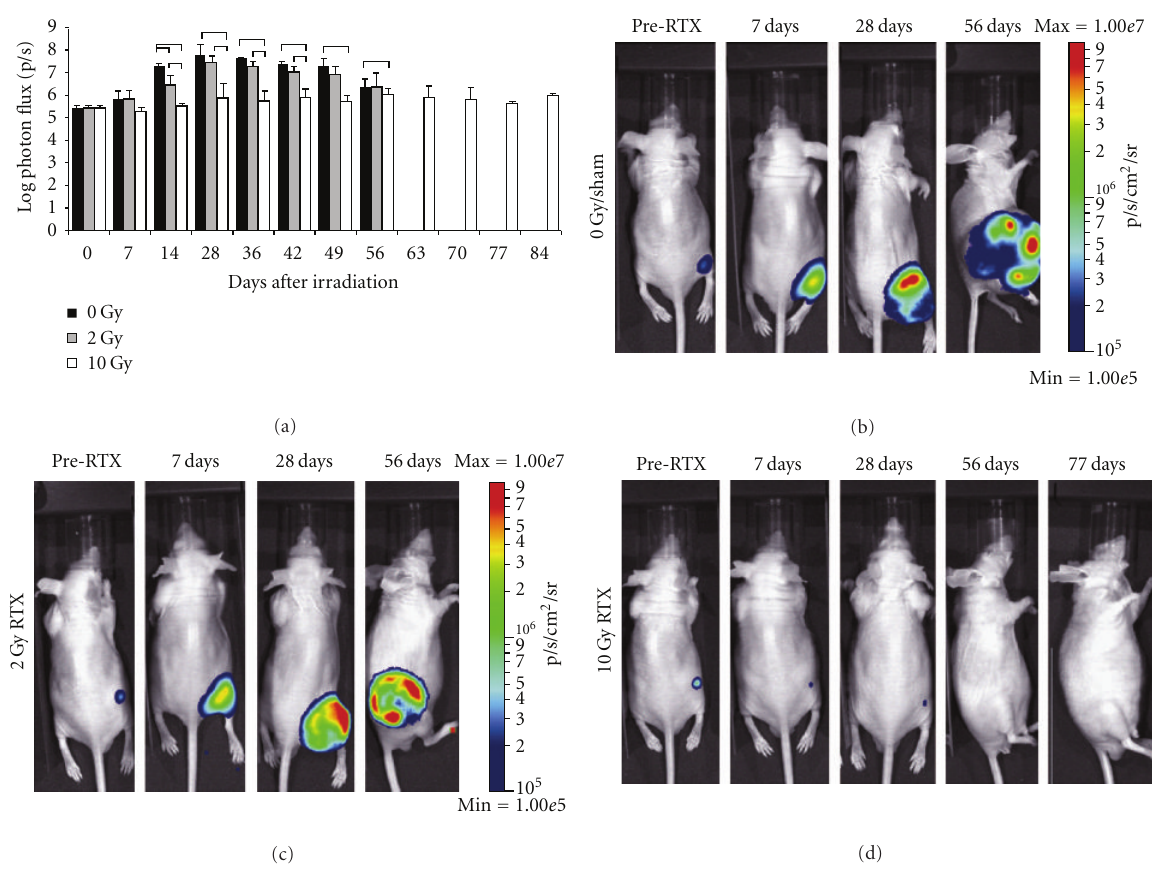
Figure 2: Serial bioluminescence imaging RC13-luc xenografts following radiotherapy with 0Gy, 2 Gy, or 10 Gy X-rays. All animals in the 0Gy and 2Gy groups were euthanized within 63 days of imaging. (a) Data presented as the mean log-transformed photon-flux (photons/second) ± 1 SD; brackets indicate P ≤ . 05 by ANOVA with Bonferroni-Dunn post hoc test. Representative images demonstrating tumor localization and growth in (b) nonirradiated, (c) 2 Gyirradiated, and (d) 10 Gy irradiated